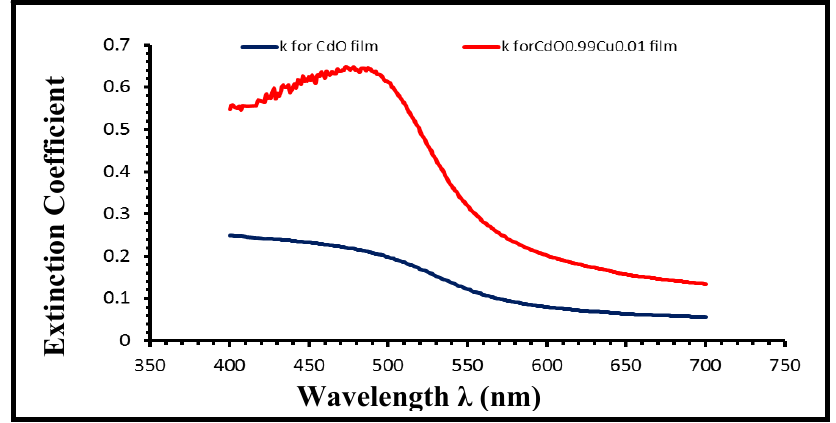
Fig.9: Extinction coefficient (k) as a function of wavelength for CdO and CdO